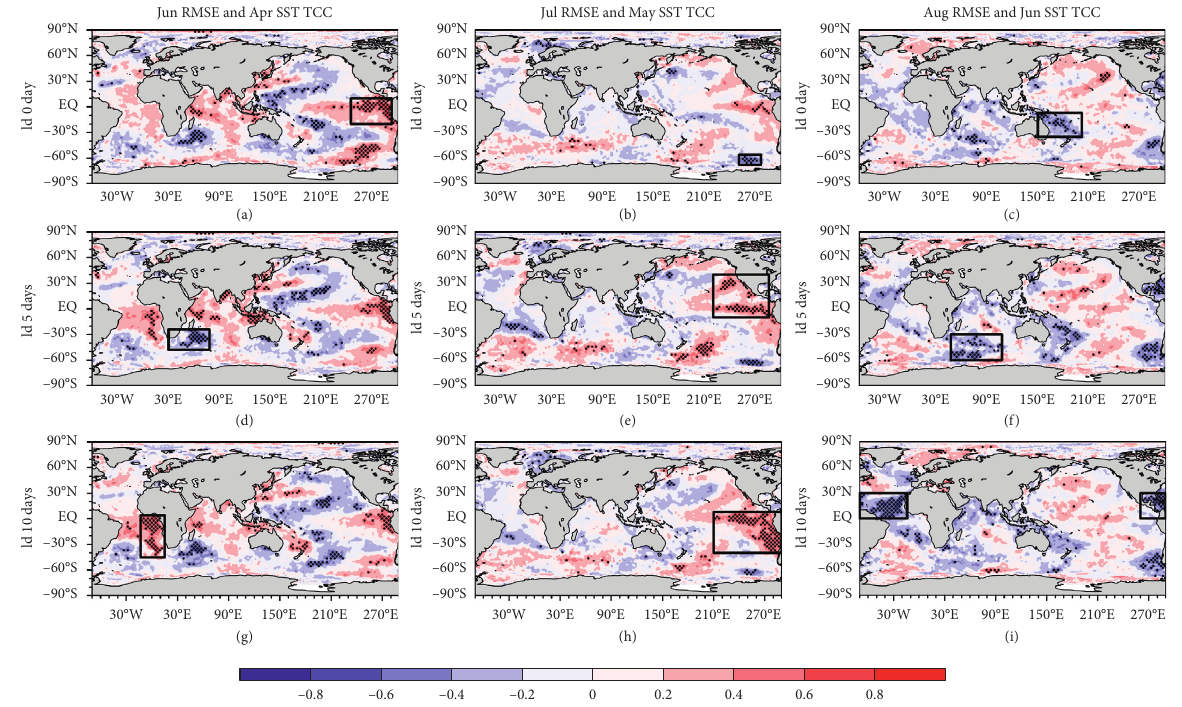
Figure 4: The spatial distribution of TCC (1995–2014) between southeast China (Reg1) monthly RMSE and monthly SST which is two months ahead of RMSE at the lead times of 0, 5, and 10 days. (a, d, g) The TCC between the RMSE of Jun and the SSTof Apr (b, e, h) The TCC between the RMSE of Jul and the SSTof May. (c, f, i) The TCC between the RMSE of Aug and the SSTof Jun. The monthly RMSE is calculated by the ensemble mean and observed summer accumulated ten-day precipitation for ECMWF hindcast experiment. The dots represent TCC exceeding 95% confidence level; the black rectangles stand for key regions of